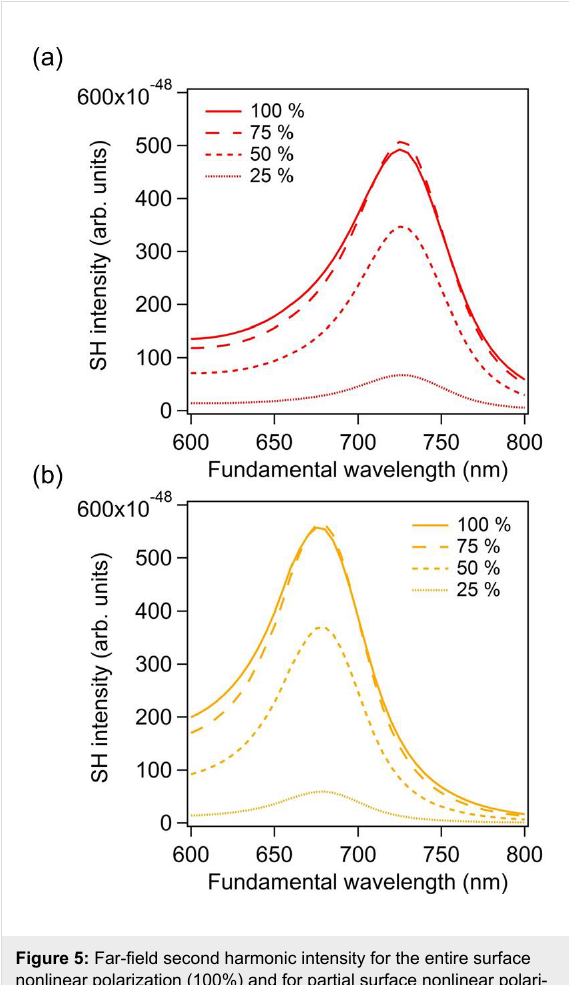
Figure 5: Far-field second harmonic intensity for the entire surface nonlinear polarization (100%) and for partial surface nonlinear polari- zations. The percentages indicate the ratio between the length over which the surface nonlinear polarization does not vanish and the length of the nanorod, see Figure 4. The gap between the nanorods is 5 nm for the panel (a) and 20 nm for panel (b).